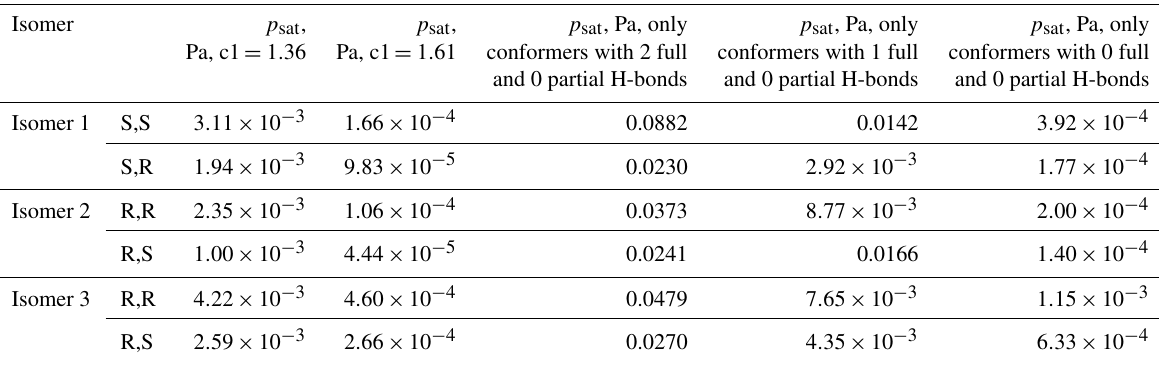
Table 4. Saturation vapor pressures, at 298.15K, of C 5 H 10 O 6 structural and stereoisomers, computed using COSMOtherm and the BP_TZVPD_FINE_18 parameterization (based on BP/def2-TZVPD//BP/def-TZVP quantum chemical data) with the Systematic conformer sampling scheme and with either modified values of the H-bonding enthalpy parameter c1 or using only conformers with a restricted number of full intramolecular